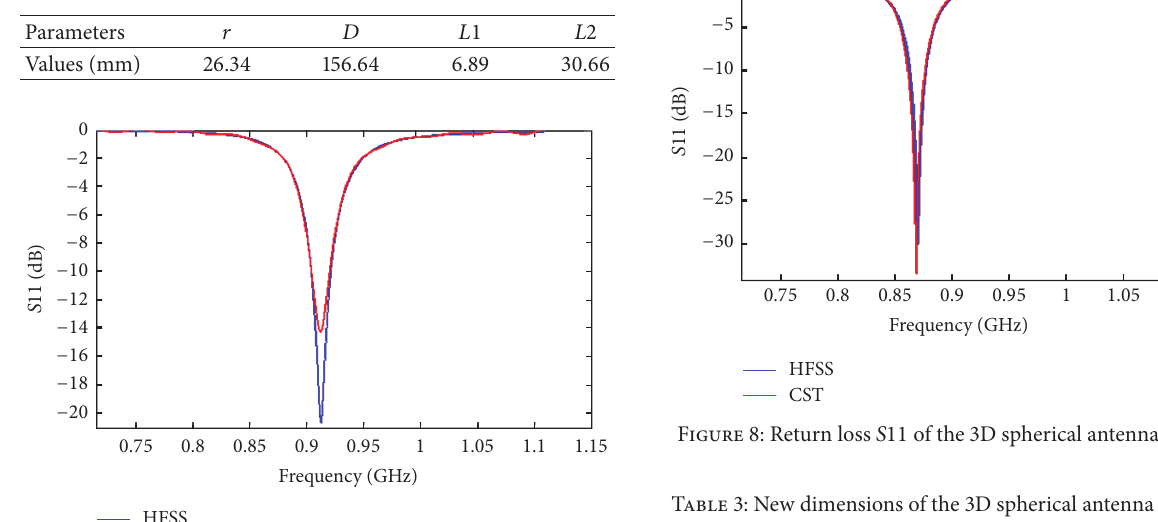
Table 2: Dimensions of the 3D spherical antenna (Figure 6).